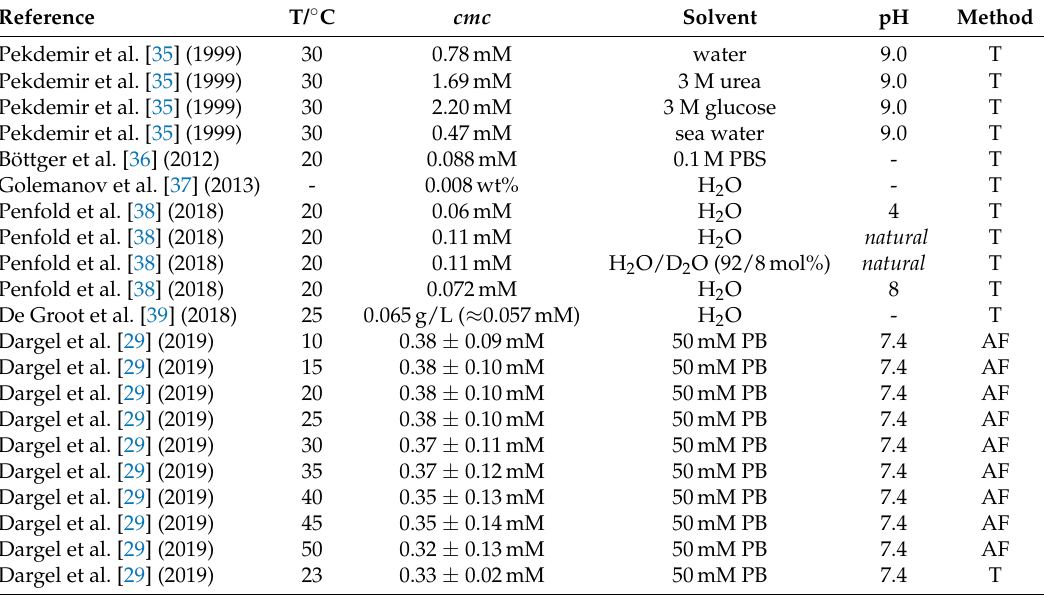
Table 1. Critical micelle concentrations ( cmc ) of β -aescin. (Used abbreviations: PB: phosphate buffer, T: tensiometry, AF: